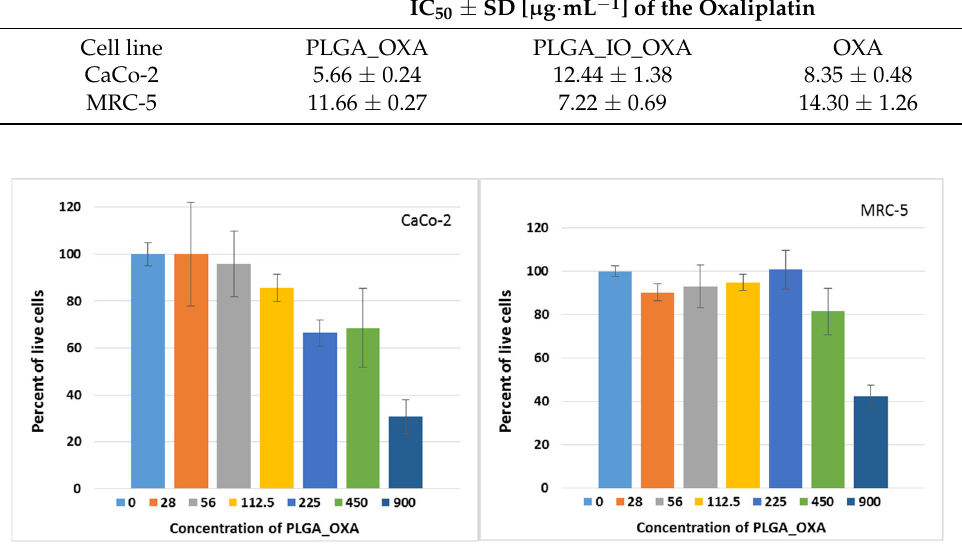
Figure 12. Evaluation of the percentage of living cells in vitro after PLGA_OXA treatment. Human cells derived from colorectal carcinoma (CaCo-2) and human primary fibroblasts (MRC-5) were treated with PLGA_OXA for 72 h.